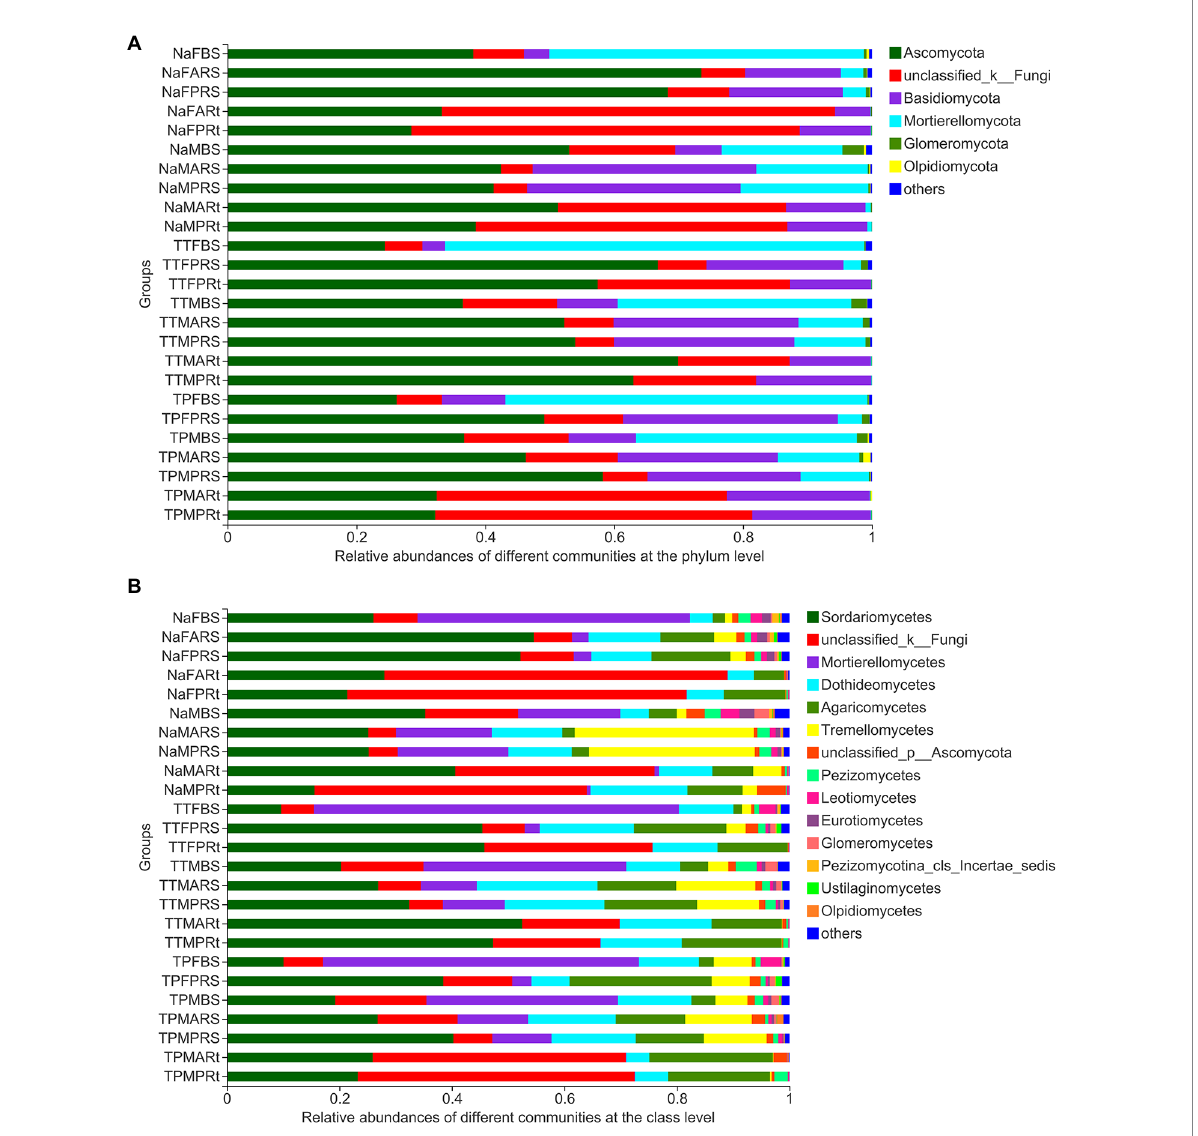
FIGURE 5 Composition of 25 groups at the phylum (A) and class (B) levels. Taxa with rich abundances are displayed on the stacked column, and those taxa with relative abundances less than 1% were combined as others. The treatment details are shown in Figure